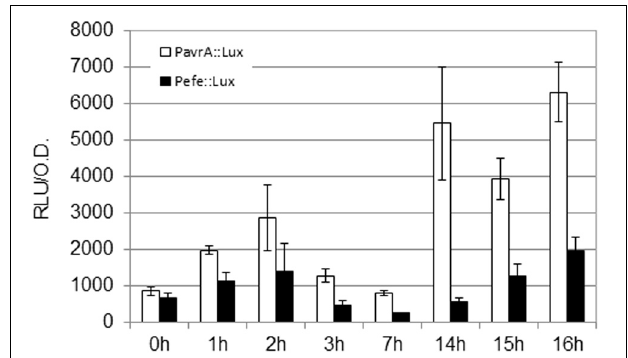
FIGURE 2 | Expression profile of HrpG -controlled genes in co-culture with Arabidopsis cells. Luminescence was measured from R. solanacearum GMI1000 carrying fusions of the avrA or efe promoters to the luxCDABE reporter (PavrA-lux or Pefe-lux, respectively). Growth conditions and units as in Figure 1 .